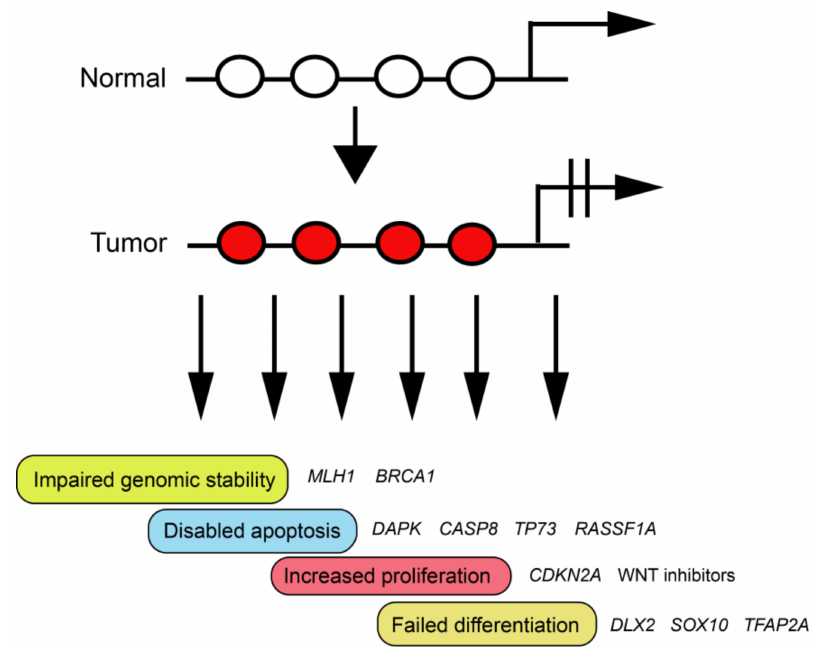
Figure 3. Potential tumor-driving consequences of CpG island hypermethylation. When DNA hypermethylation occurs at gene regulatory elements, the resulting gene silencing may have a tumor-promoting effect if the targeted genes function within the framework of the ‘hallmarks’ of cancer. These genes include, for example, DNA repair genes, genes encoding factors involved in cell growth control, or genes involved in promoting apoptosis or cell differentiation. Some examples are shown. White circles indicate unmethylated CpG sites and red circles show methylated CpG